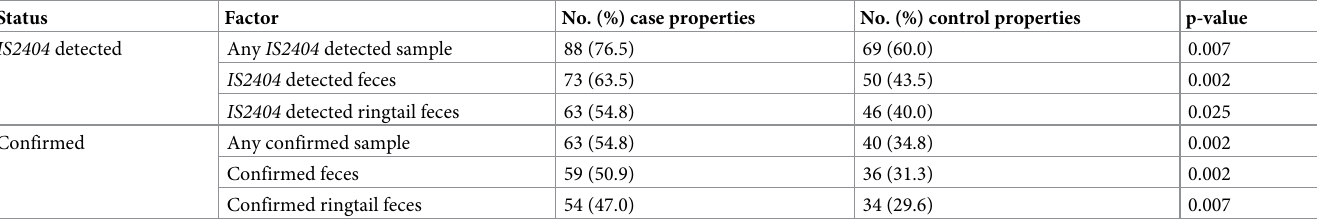
Table 2. Significant relationships observed between case properties and sample status as assessed by Chi-square